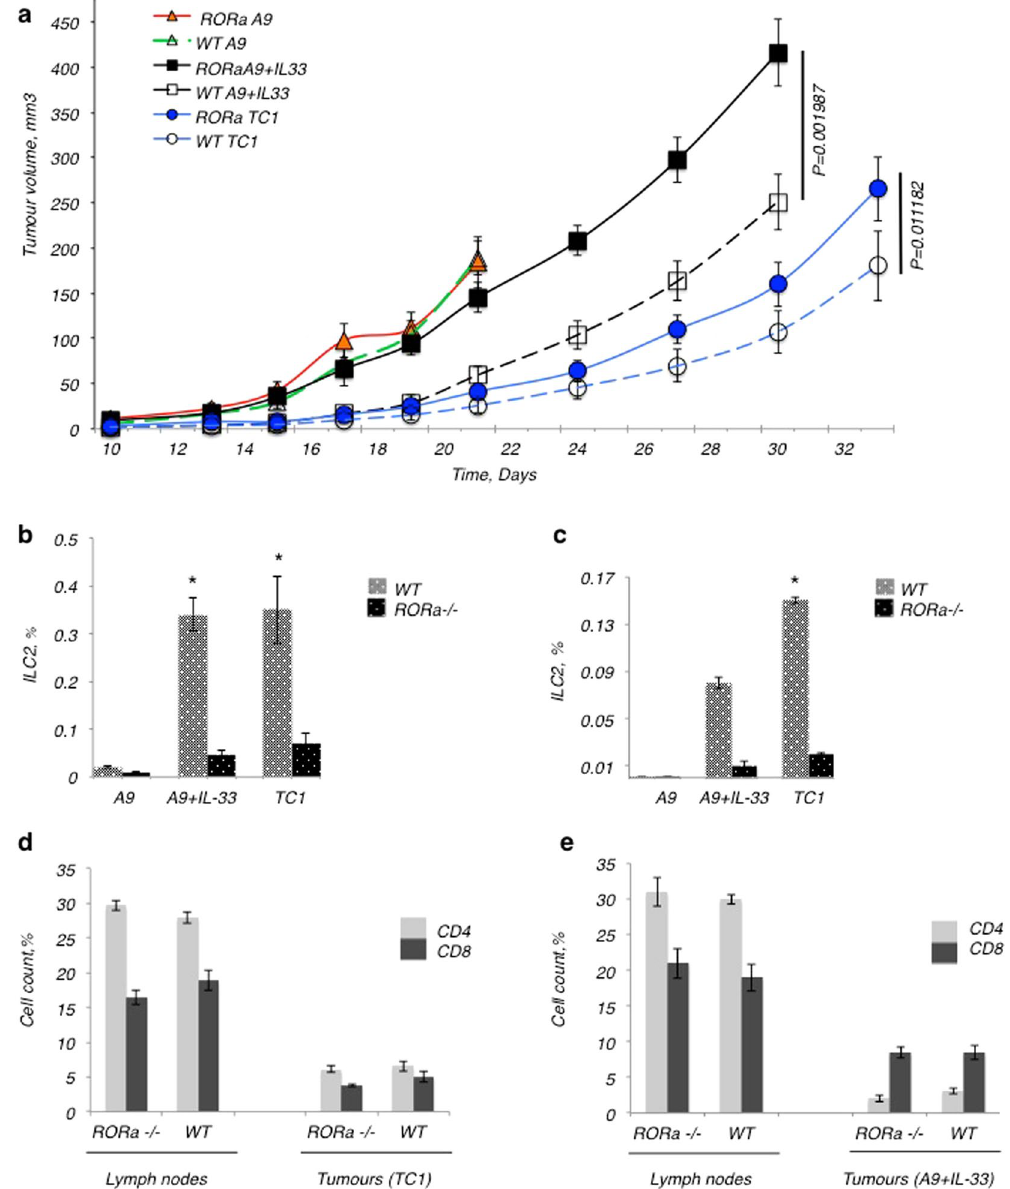
Figure 4. The mice lacking ILC2s (ROR α − / − ) were less able to limit the growth of tumours. Tumours with and without IL-33-expression were established in the WT and ROR α − / − chimeric mice. ( a ) The presence of ILC2s significantly inhibited tumour formation in WT chimeric mice bearing tumours expressing IL-33, when compared to ROR α − / − chimeras, which lacked ILC2s. Metastatic A9 tumours demonstrated rapid progression and severe disease symptoms reaching the humane end-point that resulted in early termination of animals from both A9 chimeric groups, indicating that the ILC2s were not significantly able to control the growth of fast growing tumours which lack IL-33 expression. Metastatic A9 + IL-33 tumour growth was more aggressive in ROR α − / − chimeric mice lacking ILC2s, to the point where they resembled the growth of A9 cells alone. The difference in growth results between metastatic A9 + IL-33 tumours grown in WT versus ROR α − / − chimeric mice was significant; P < 0.002 (Student t-test). Primary TC1 tumours were able to grow faster in mice lacking ILC2s (ROR α − / − chimeras) than in WT chimeras P < 0.05 (Student t-test). ( b ) The numbers of ILC2 cells found in neighbouring lymph nodes were significantly lower in ROR α − / − mice compared to WT chimeras bearing IL-33 expressing tumours. This served as a quality control for bone marrow transplantation; * P < 0.05 (Student t-test). ( c ) The numbers of ILC2 cells found in primary TC1 tumours were significantly higher than in metastatic A9 or A9 + IL-33 tumours; * P < 0.05 (Student t-test). ( d,e ) ROR α deficiency had no effect on the percentage of CD4 + or CD8 + lymphocytes found in either lymph nodes or tumours in response to ( d ) primary TC1 or ( e ) metastatic A9 + IL-33 tumours. The percentage of all cells was calculated as a fraction of 2 × 10 5 cellular events used to create a profile for each organ or tissue. The error bars represent standard error of the mean; n = 8 mice per